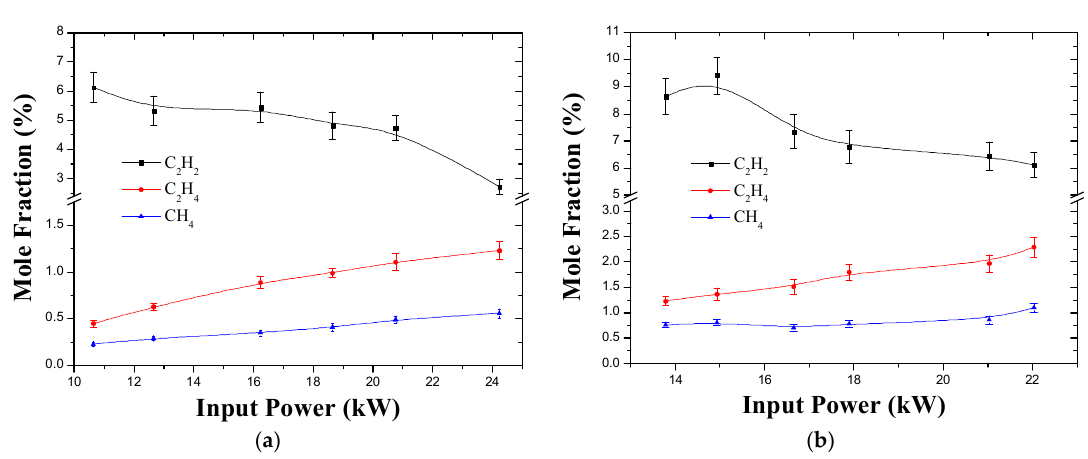
Figure 3. Effects of input power on the product gas composition at feed rate of 12 g/min ( a ) and 17.65 g/min ( b ) (Carrier gas flow rate: 1 Nm 3 /h; working gas flow rate: 5 Nm 3 /h; magnetic flux intensity: 0.077 T).